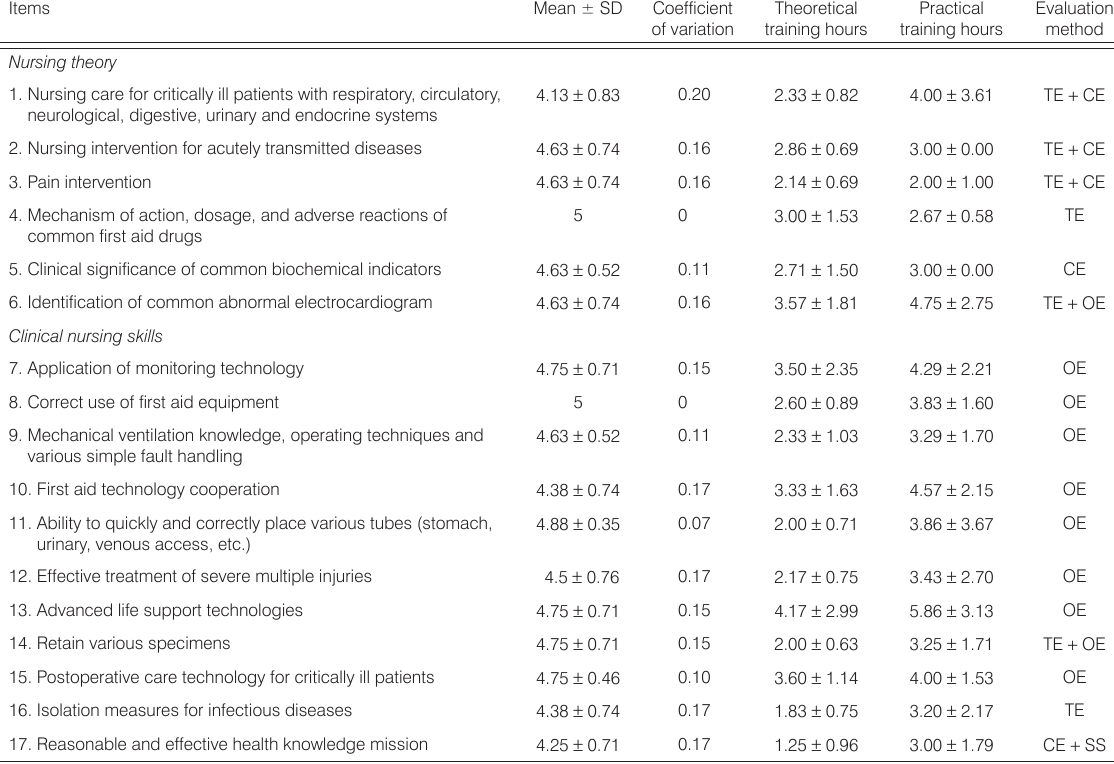
Table 2. Core competencies of backup nurses for professional practice